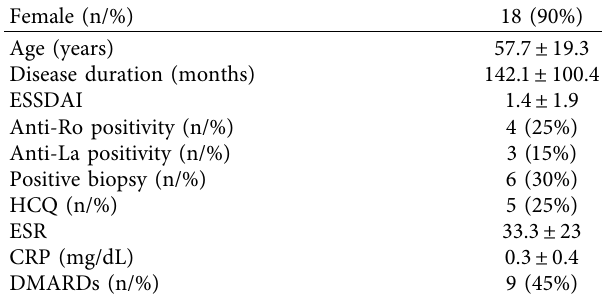
Table 1: Characteristics of the study